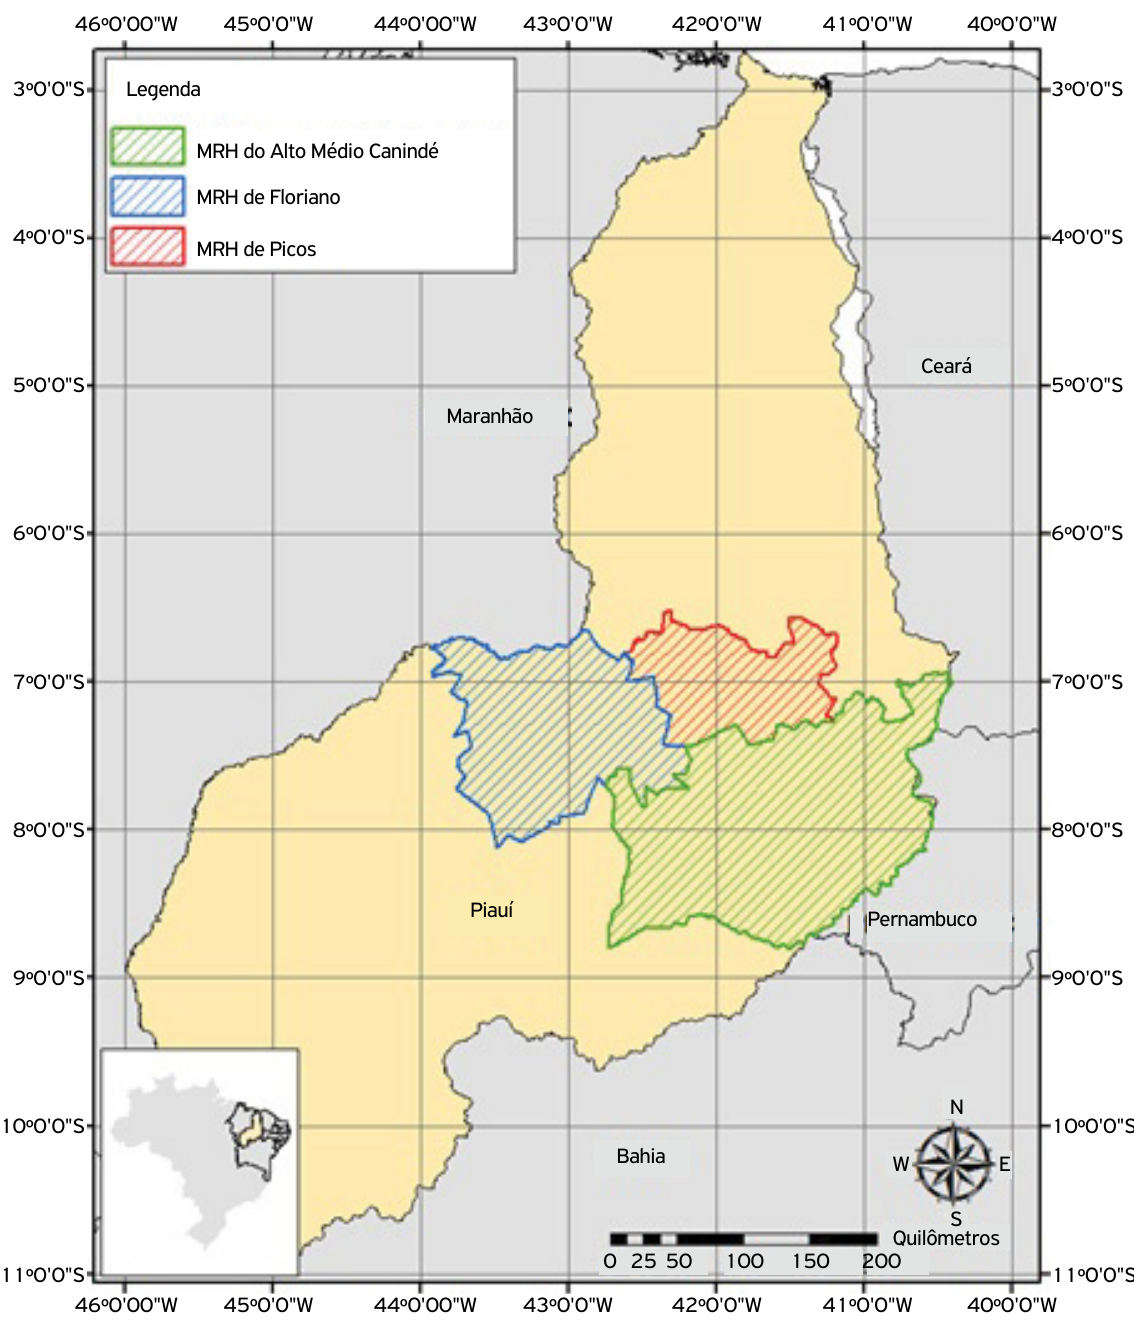
Figura 1. Microrregiões do Alto Médio Canindé, Picos e Floriano, Piauí, Brasil (BRASIL,